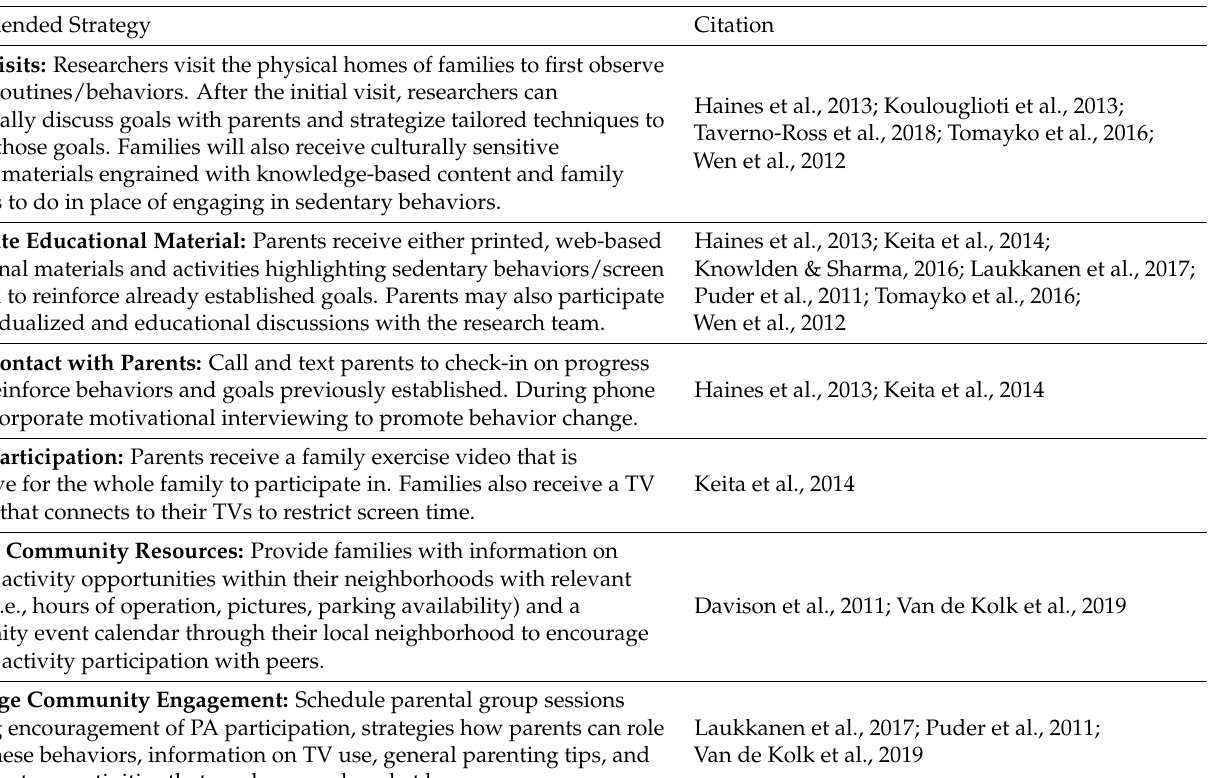
Table 6. Recommended home- and community-based strategies for early childhood sedentary behaviors/screen time